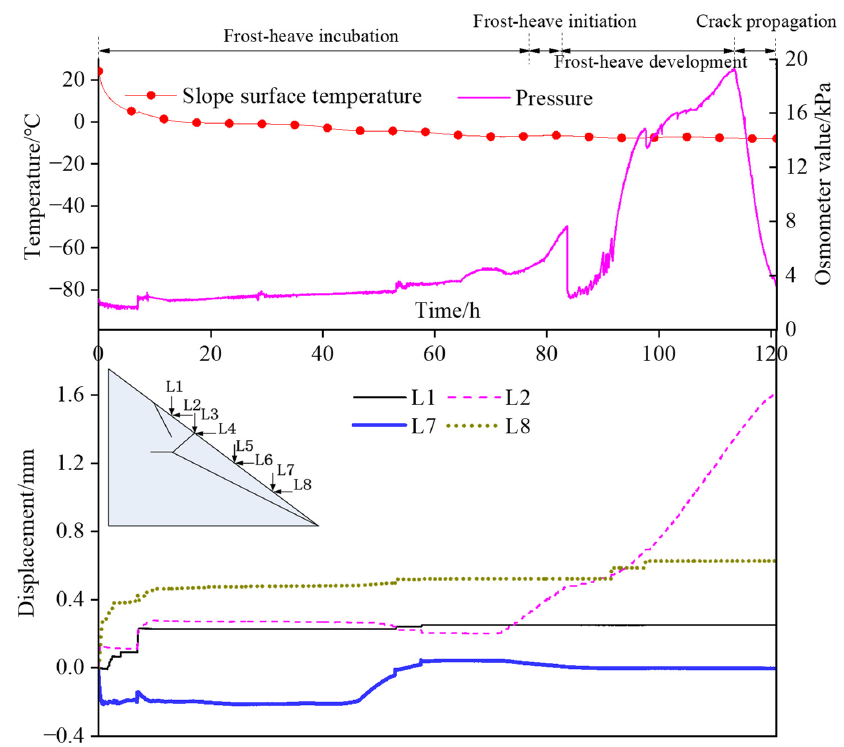
Figure 6. The variation curves of the measured variables during the cooling process.